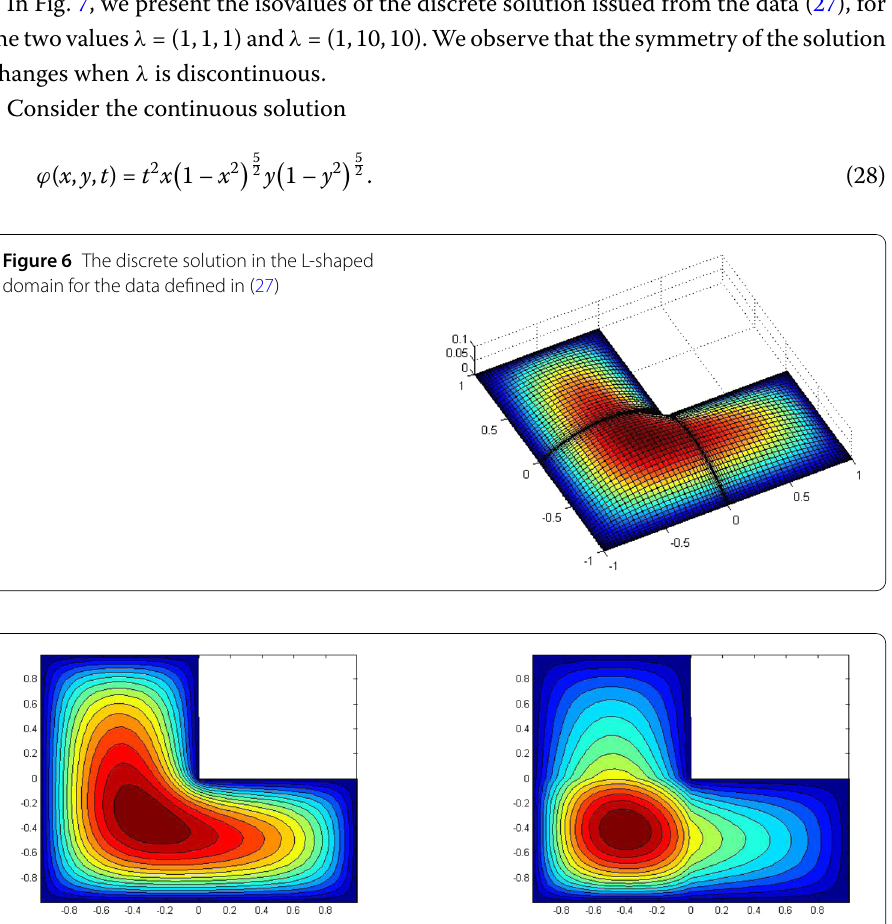
Figure 7 The isovalues of the discrete solution issue from (27) for λ = (1,1,1) (left) and λ = (1,10,10)